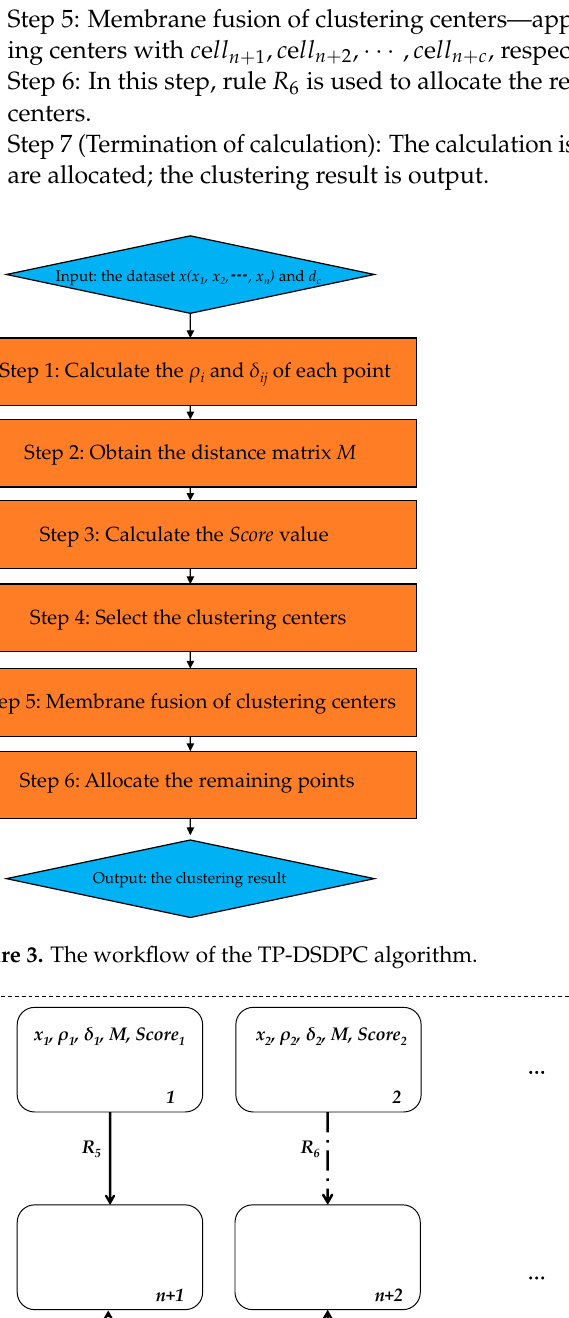
8 of 19 Figure 2. The initial configuration of the tissue — like P system. 3.4. The Process of TP-DSDPC Algorithm The whole algorithm has seven main steps. The workflow chart of the TP-DSDPC algorithm is shown in Figure 3. Figure 4 displays the realization process of the tissue — like P system. •